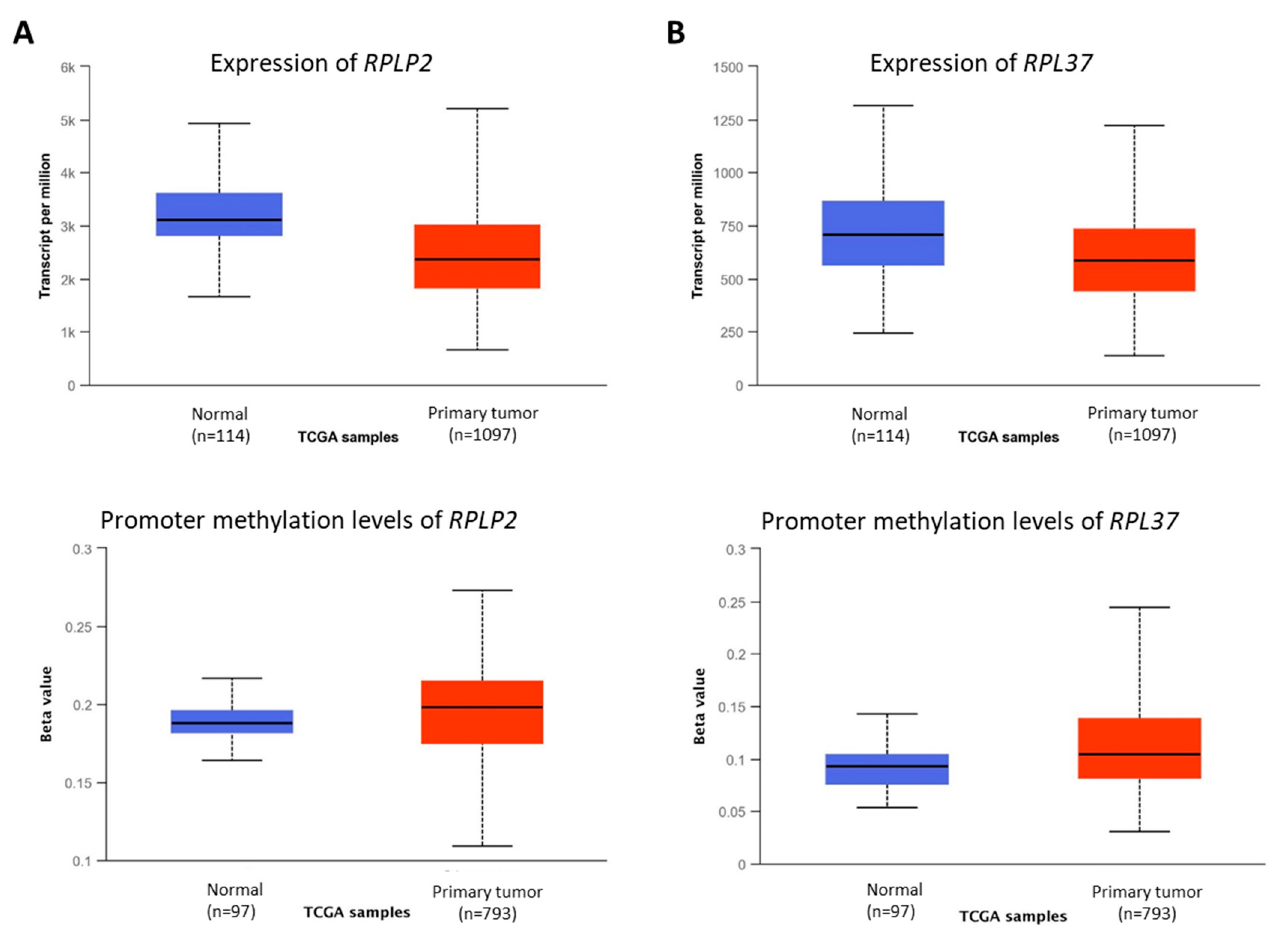
Figure 4. Relative mRNA expression and promoter methylation levels of the genes downregulated in cancer cells but upregulated by crocodile serum. ( A ). RPLP2 , ( B ). RPL37 . (Note: for all the box- plots, p < 0.001).